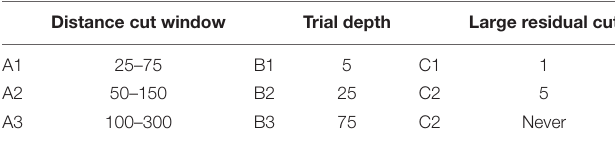
TABLE 1 | Settings used in the multi-parameter procedure. Distance cut window Trial depth Large residual